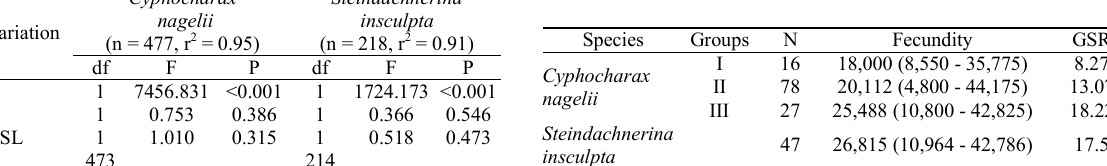
Fig. 4. Frequency distribution of oocytes diameters of Cyphocharax nagelii according to the developmental groups. Table 3. Number of mature females analyzed (N), mean fecundity (and range), and mean gonadosomatic relationship (GSR) to Curimatidae